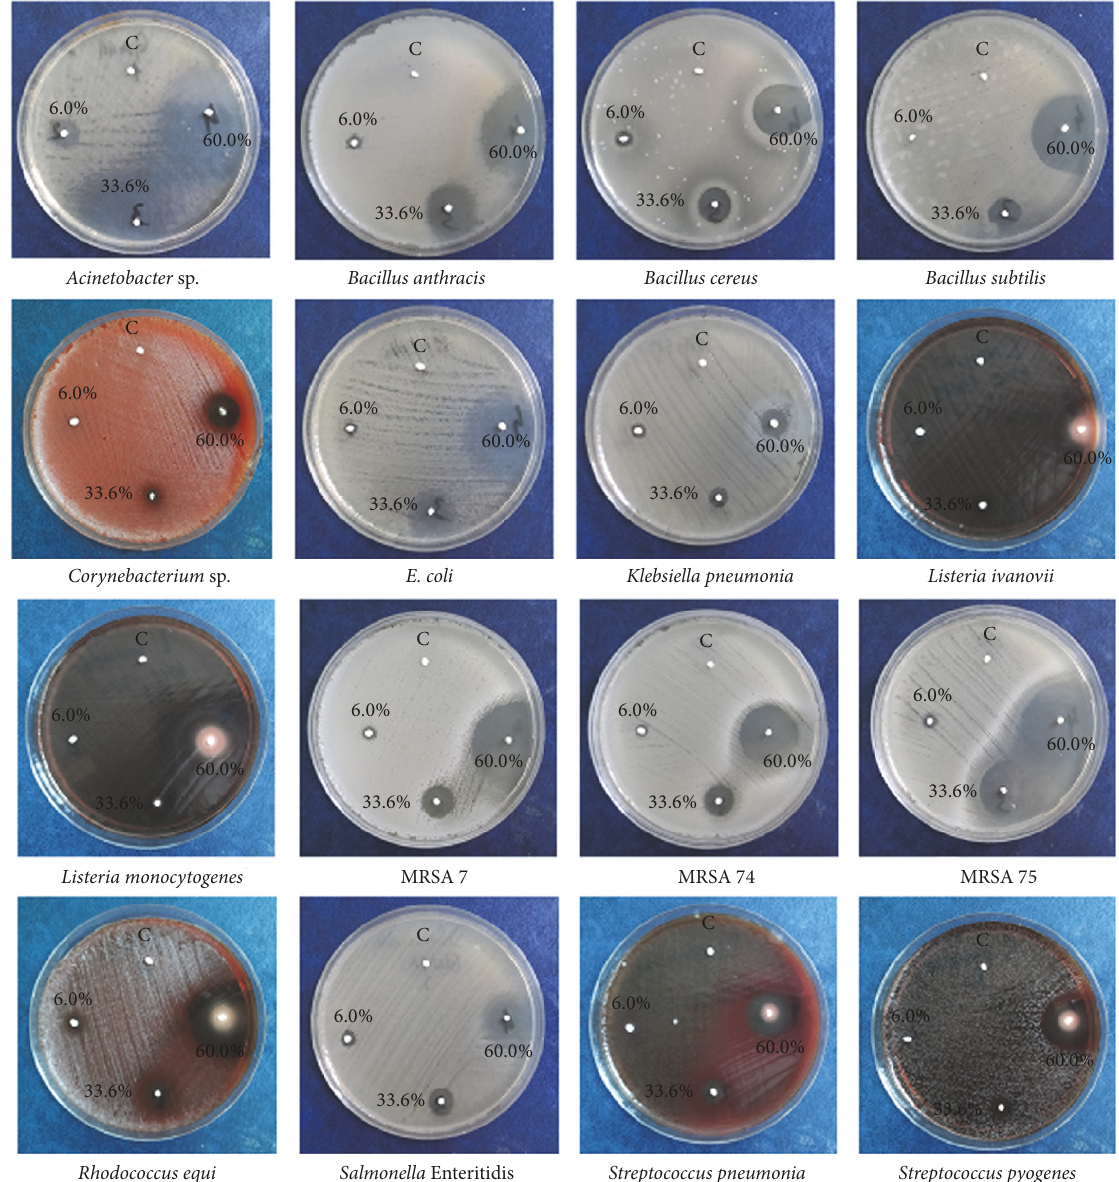
Figure 6: Inhibition zones of the tested